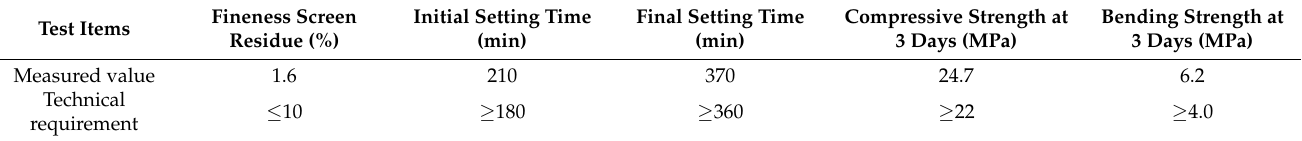
Table 3. Technical indexes of cement.